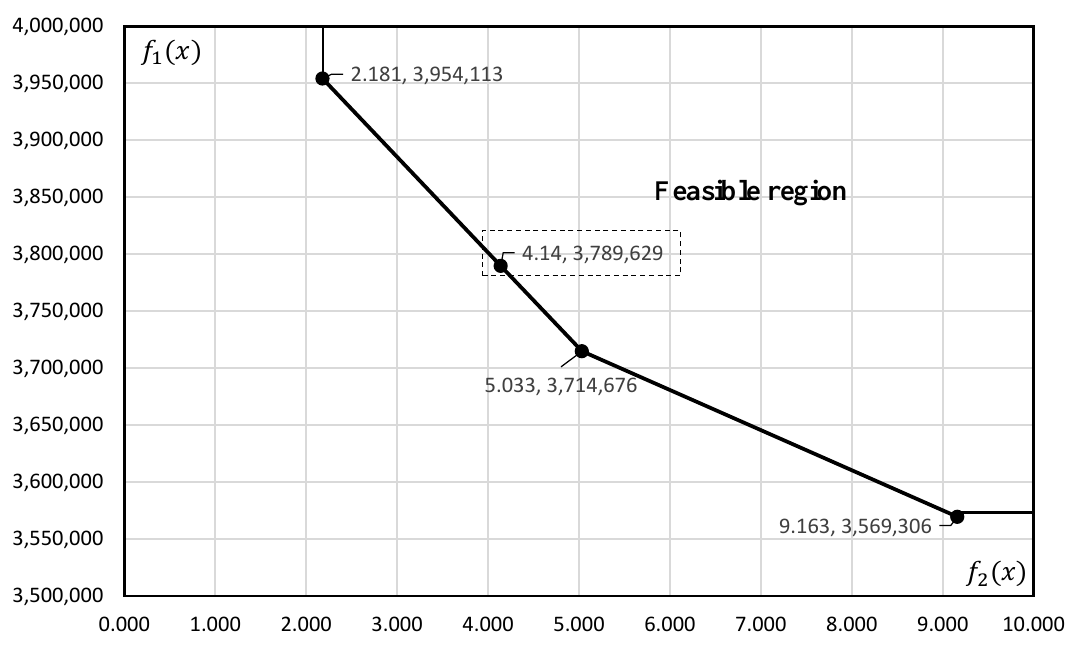
Figure 3. The result from the interactive fuzzy programming with a priority control method.